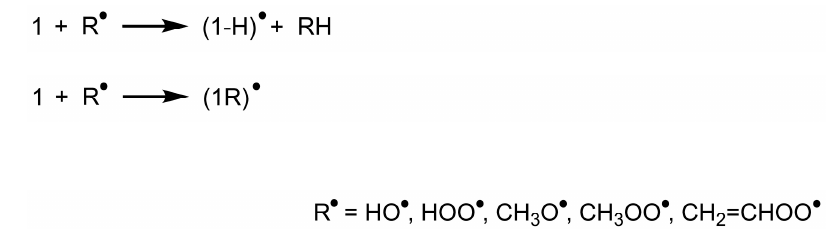
Figure 2. Hydrogen atom transfer (HAT) and radical adduct formation (RAF) in fluoxetine ( 1 ).